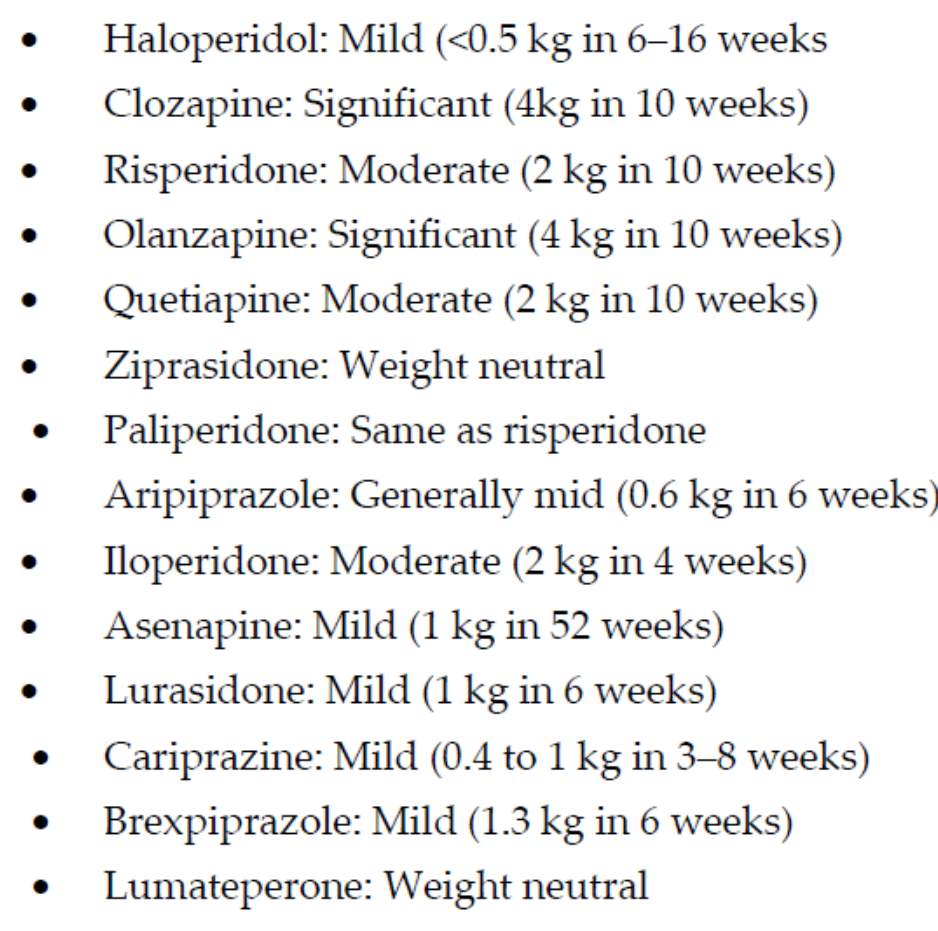
Figure 3. Weight gain with antipsychotic medications.